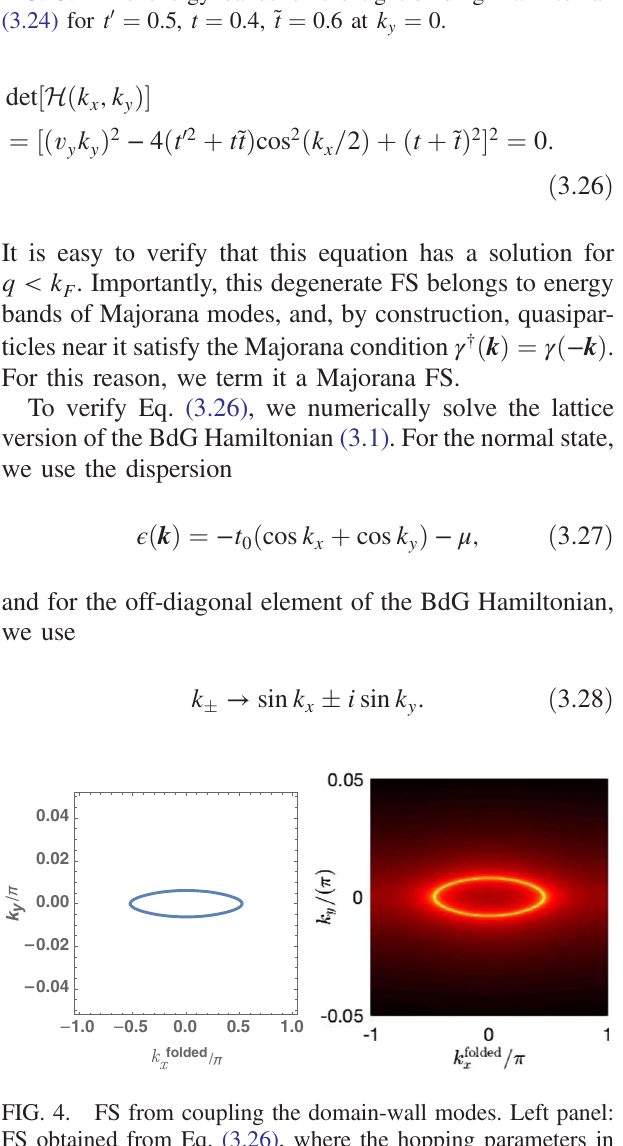
FIG. 3. The energy bands of the tight-binding Hamiltonian